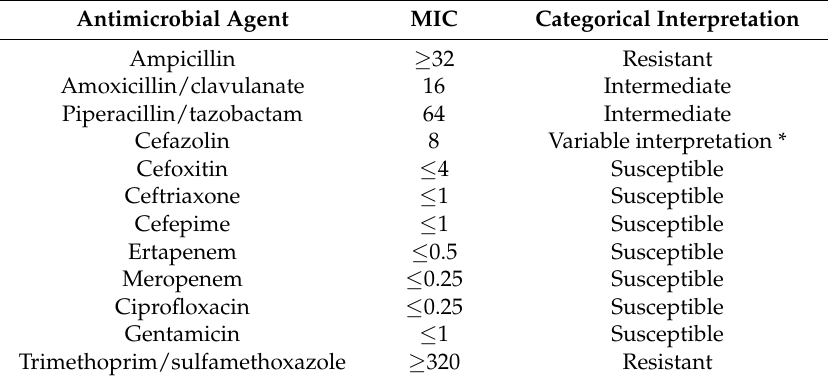
Table 1. In vitro antimicrobial susceptibility results of E. coli